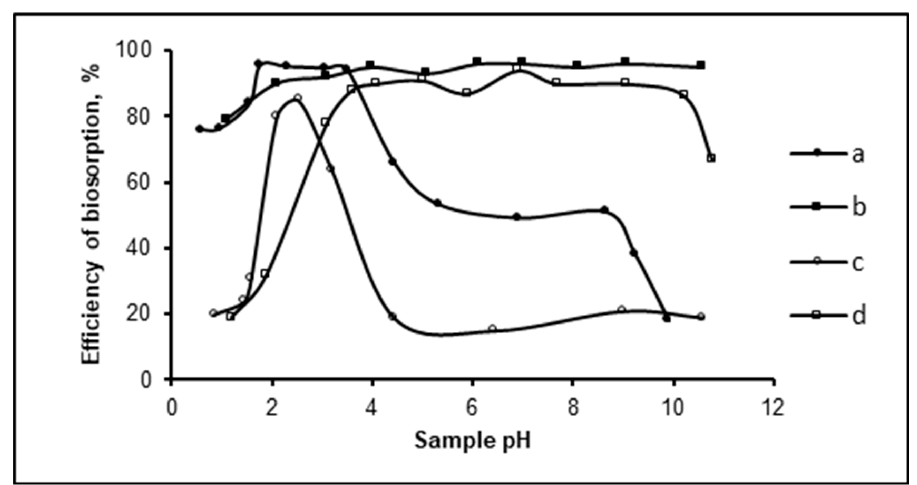
Figure 1. Influence of sample pH on the efficiency of biosorption of Pt (0.1 mg L − 1 ) and Pd (0.075 mg L − 1 ) on yeast Saccharomyces sp. and fungi Aspergillus sp. (contact time 60 min): a—Pt(IV) on yeast; b—Pt(IV) on fungi; c—Pd(II) on yeast; d—Pd(II) on fungi.